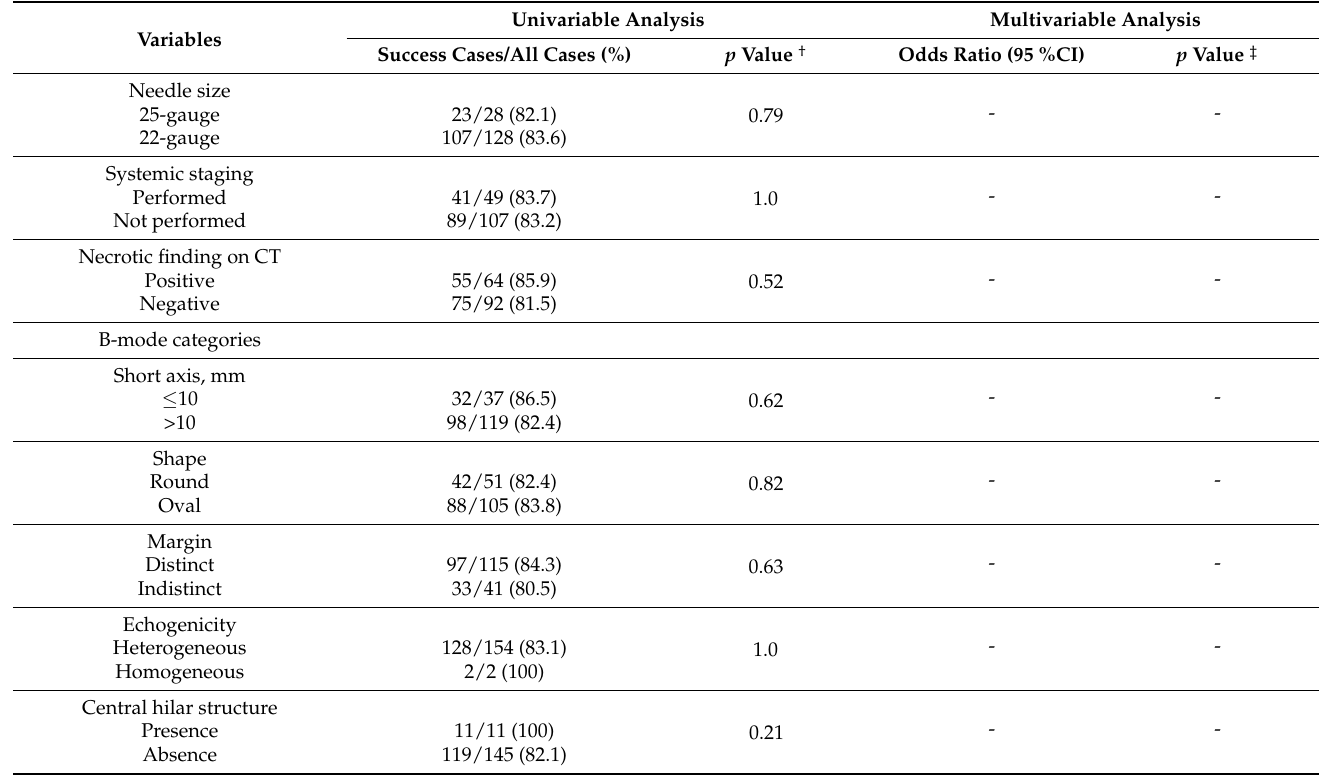
Table 3. Logistic regression analysis of clinical factors affecting the success rate of next-generation sequencing using specimens obtained through